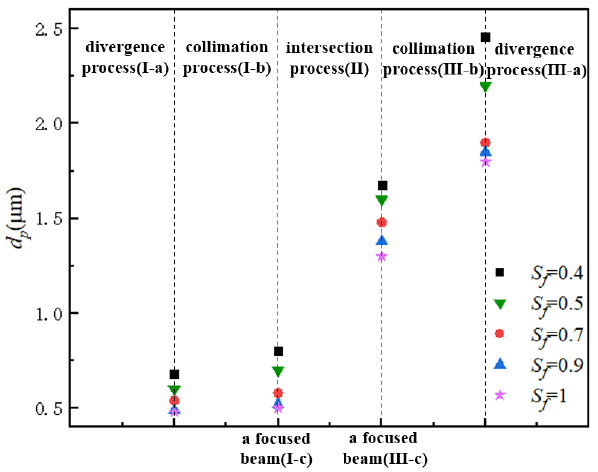
Figure 12. Al particle with variable shape factors in different processes .